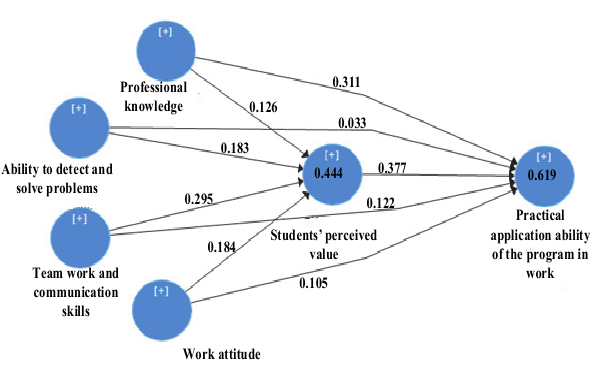
Fig. 2. Structural